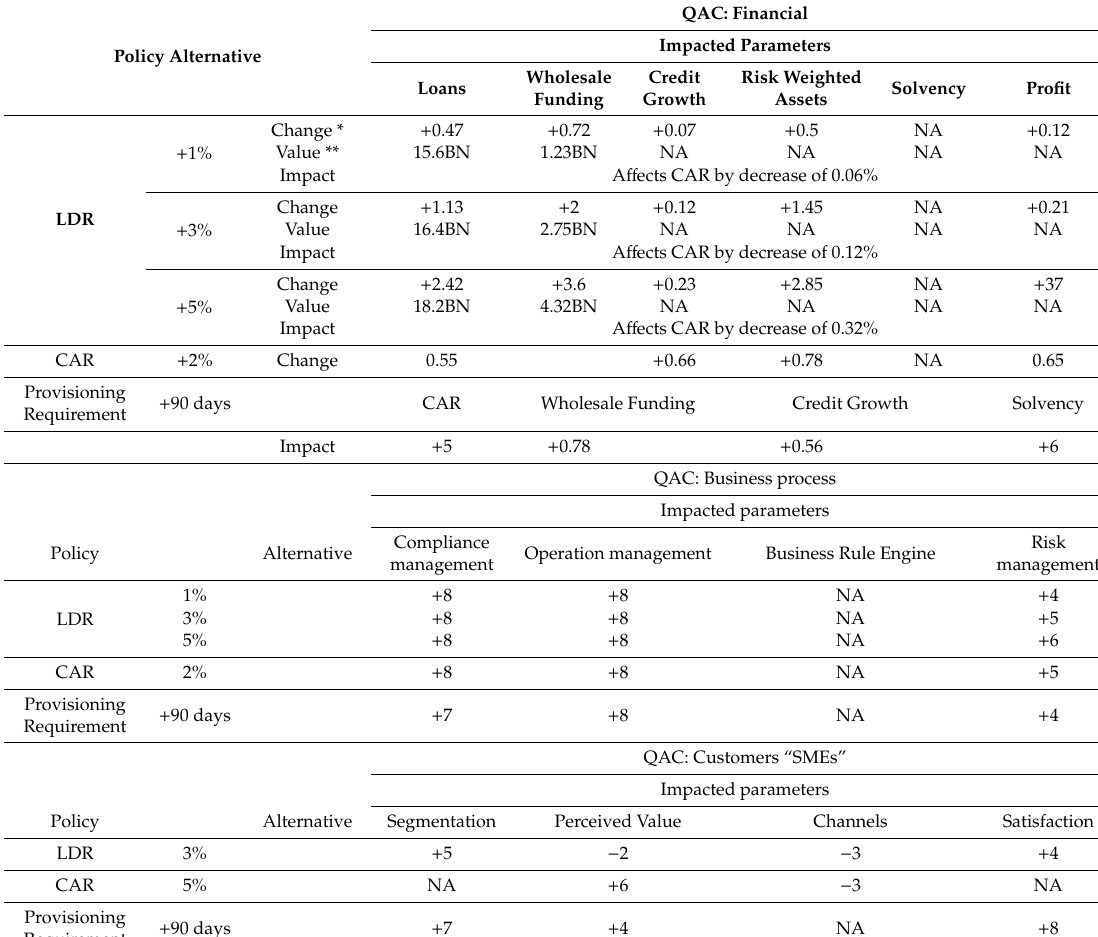
Table 2. Simulation results of three quality attribute constraints (QACs): Financial, Business Process and